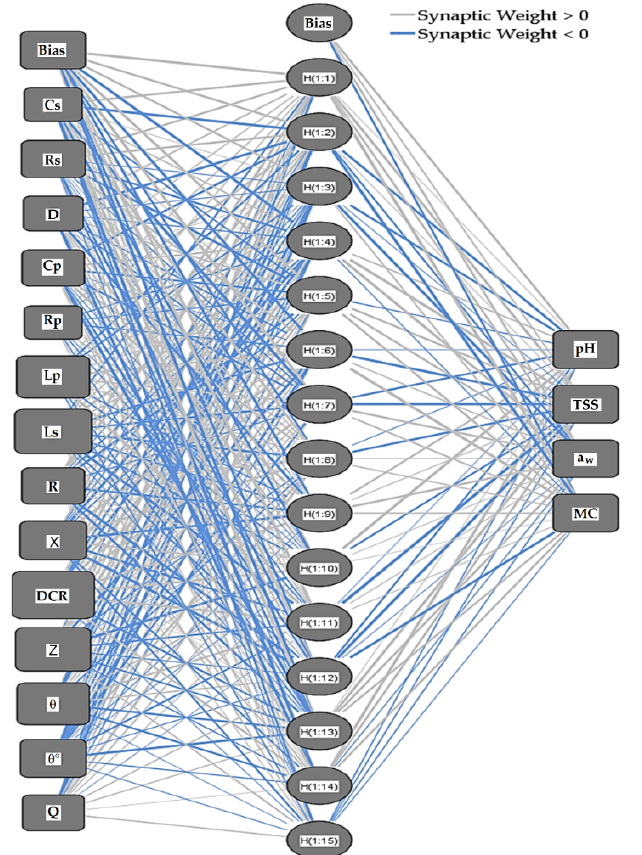
Figure 5. Network diagram of the ANNs prediction model to predict the pH, TSS, a w , and MC of the date fruits during cold storage based on their electrical properties (Cs, Rs, D, Cp, Rp, Ls, Lp, R, X, DCR, Z, ϴ , ϴ °, and Q) at 10,000 Hz. The hidden layer activation function is Hyperbolic tangent, and the output layer function is Identity.